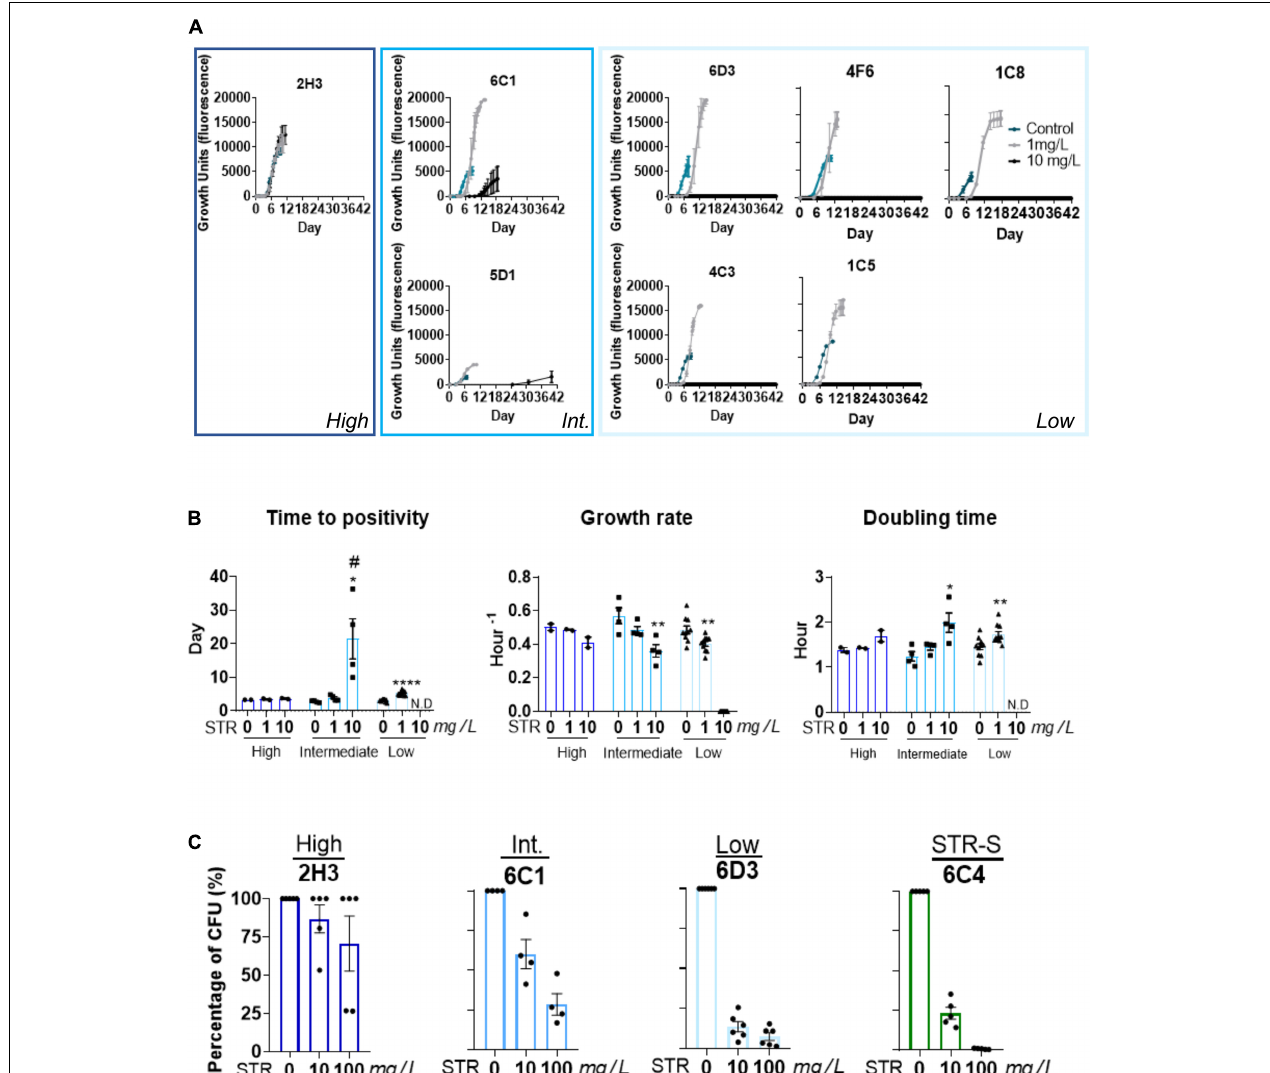
FIGURE 3 | Heterogeneous growth rates in the presence of STR among strains from the same transmission cluster. (A) Comparison of the growth of M. tuberculosis isolates within TC1 (2H3, 6C1, 5D1, 6D3, 4F6, ICS, 4C3, and 1C5), in absence or presence of STR. The concentrations used were 1.0 mg/L. (gray curve) and 10.0 mg/L (black curve) of STR. The condition without STR was used as the control, represented with a blue curve. (B) Comparison of the growth parameters, time to positivity; growth rate, and doubling time of the strains with different STR resistance levels. Low STR resistance level (light blue) intermediate STR resistance level (blue), and high STR resistance level (dark blue). Time to positivity: the time needed to achieve the threshold of 75 GU in the BACTEC MGIT 960 system, growth rate of each isolate, doubling time: the time required for the bacteria density duplicate. The growth rates and doubling times were calculated in the exponential phase of growth. N.D means not detected. The error bar represents SEM values ( n = 2 for each isolate). Statistical analysis was performed using Student’s t -test or one-way ANOVA. Significant statistical differences comparing 0 mg/L of STR to the other conditions are represented by *, and to 1 mg/L of STR by #(# or, * p < 0.05; ** p < 0.01; *** p < 0.001; and **** p < 0.0001). (C) Percentage of survival of the intracellular bacteria after incubation with 10.0 or 100.0 mg/L of STR. The intracellular bacteria were quantified by CFU enumeration six days post-infection. Representation of the TC1. STR resistant strains with high STR resistance level (dark-blue), STR resistant isolates with intermediate resistance level (blue), STR resistant isolate with low resistance level (light-blue). STR-S refers to STR susceptible isolate